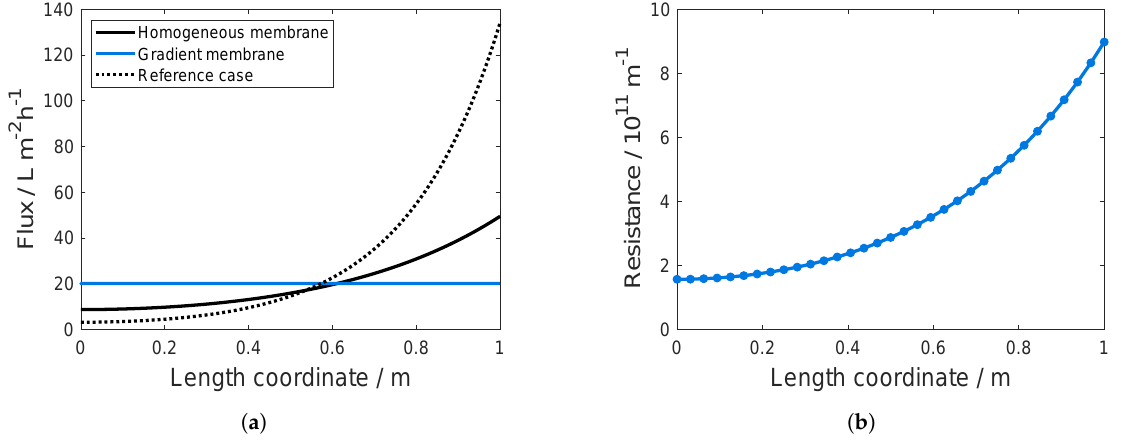
Figure 6. Optimization of membrane fiber with an increased radius of 0.3 mm and comparison to reference case with radius of 0.2 mm; flux profiles J ( x ) ( a ) and optimized resistance profile R m ( x ) ( b